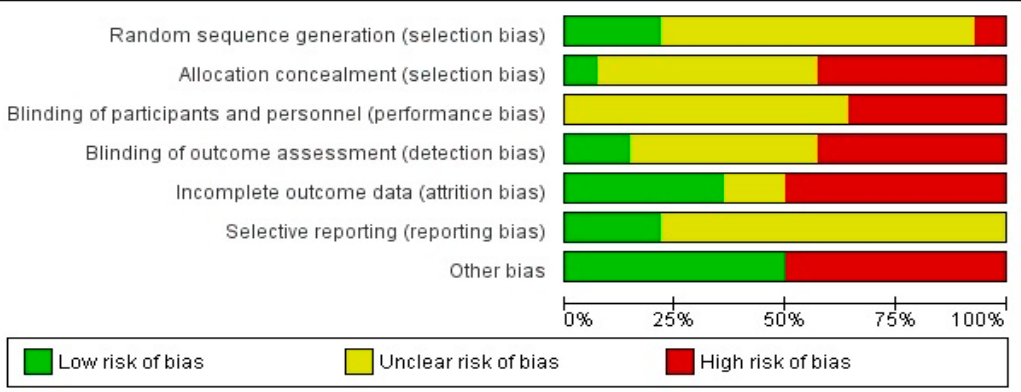
Figure 3. Risk of bias graph: review authors’ judgments about each risk of bias item, which are presented as percentages across all of the included intervention studies ( n = 14).